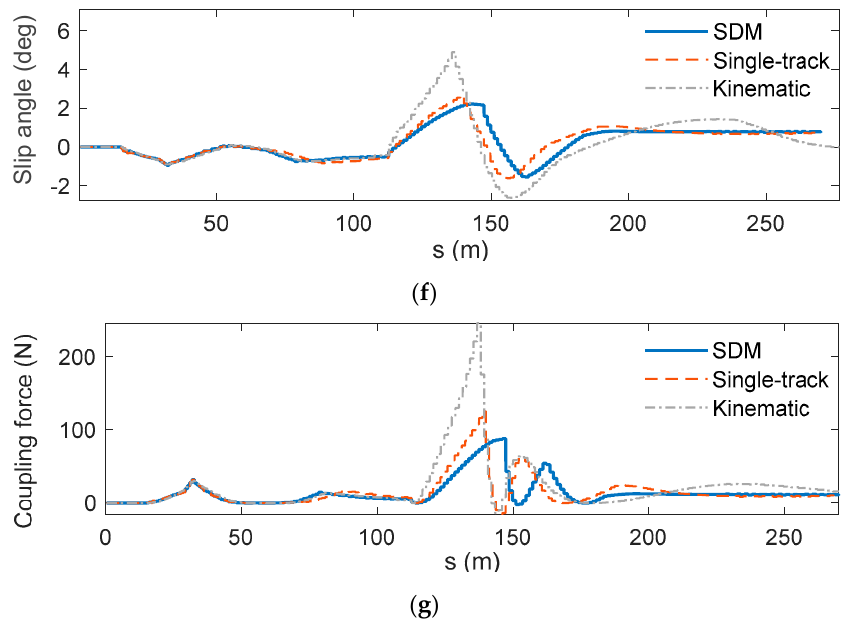
Figure 11. Results of SCENARIO 3. ( a ) Vehicle trajectories. ( b ) Longitudinal driving force. ( c ) Steering angle of front tire. ( d ) Longitudinal speed. ( e ) Lateral error. ( f ) Slip angle of front tire. ( g ) Longitudinal coupling components of lateral force of front tire.